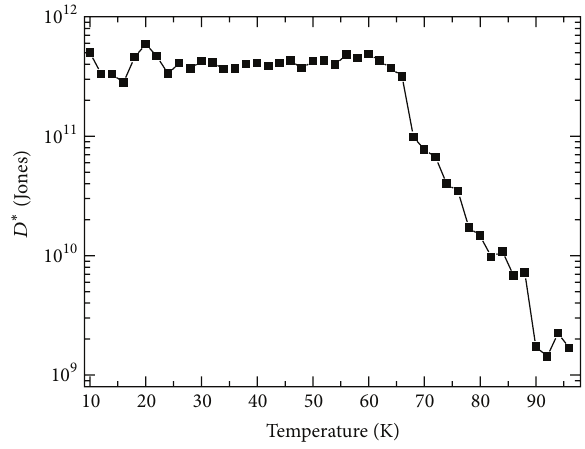
Figure 5: Peak wavelength